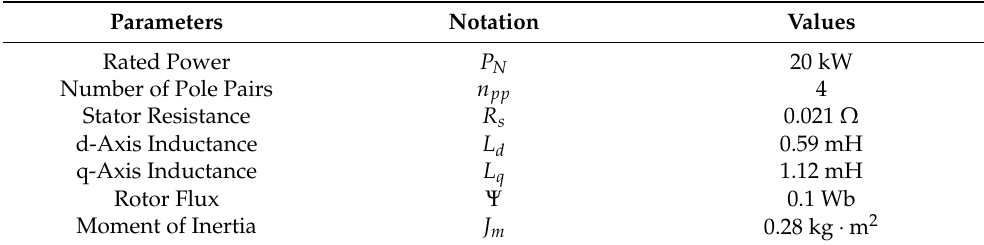
Table 1. Parameters of the IPMSM. (Reprint with Permission [35]; 2018, Proceedings of the 2018 XIII International Conference on Electrical Machines (ICEM)).